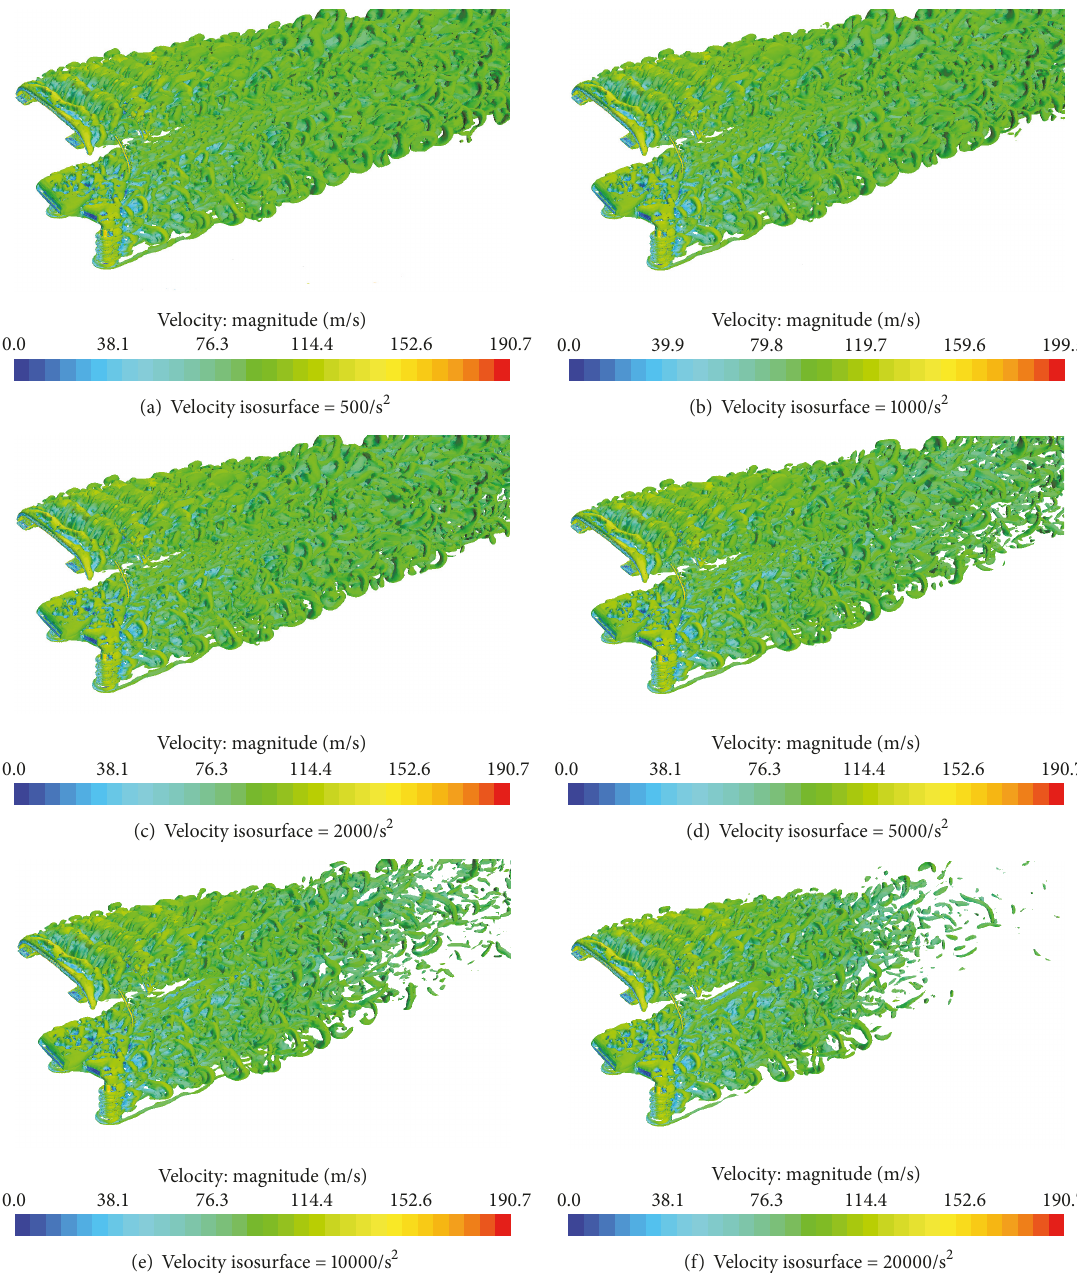
Figure 9: Distribution contours of velocity isosurface based on Q-criterion for pantographs.